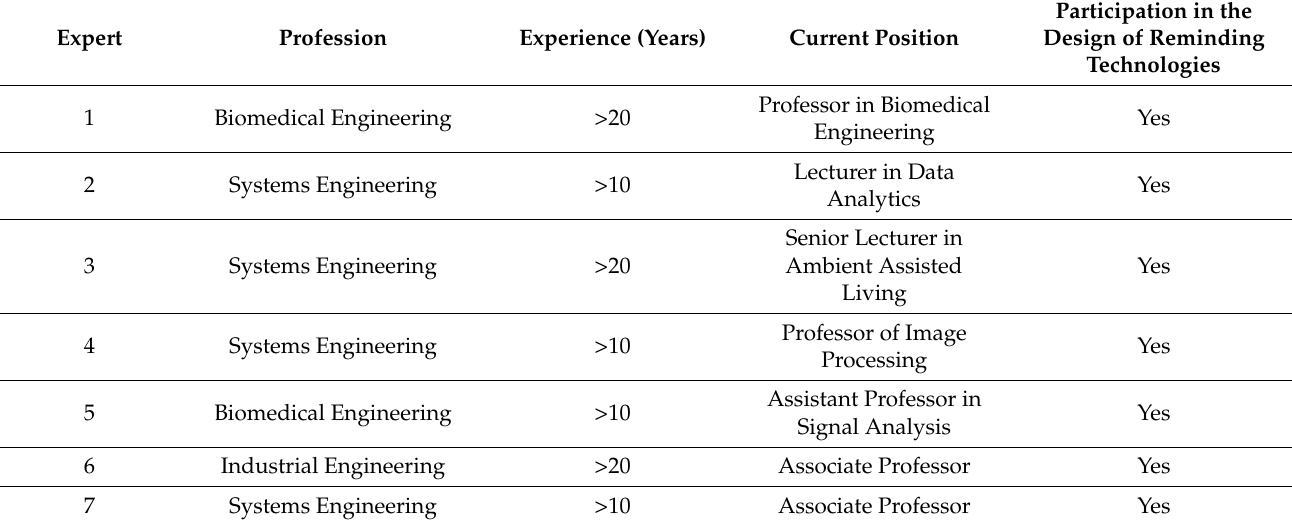
Table 1. Profile of decision-making